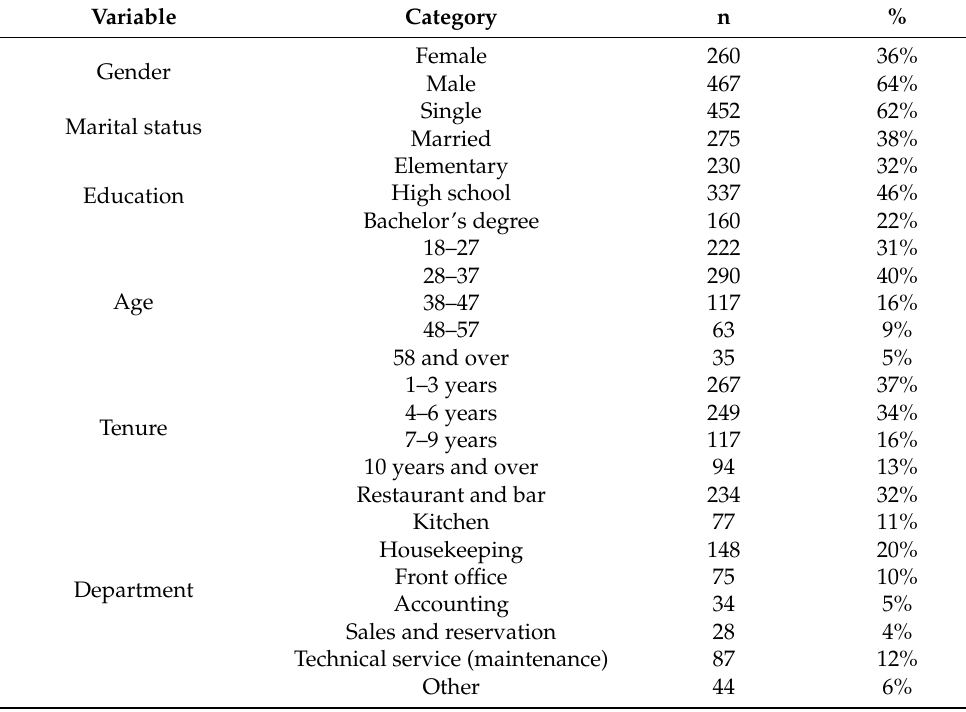
Table 1. Characteristics of the participants (n =